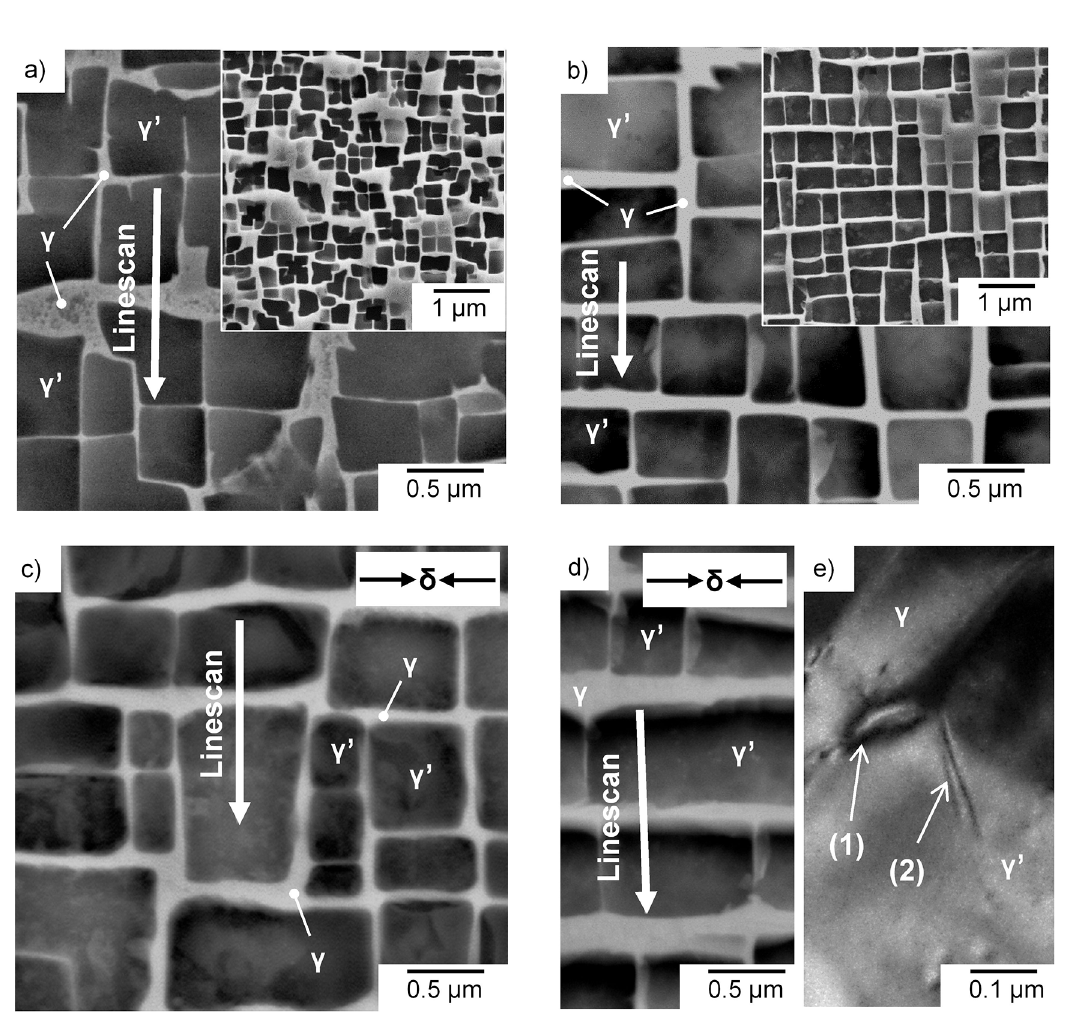
Figure 1. Back scattered electron images recorded perpendicular to the [001]-(loading-)direction of the etched CMSX-4 specimens: a) as-cast condition; b) multi-stage heat treated state; c) at 0.01 % creep strain (950°C, 150 MPa, 2 h), d) at 0.5 % creep strain (1050°C, 150 MPa, 3 h); measuring positions of EDS-linescans depicted and e) TEM image of severely creep deformed state with (1) interfacial dislocation and (2) super dislocation; plan of foil [011]; type of the total Burgers vectors of (2) was determined as b =